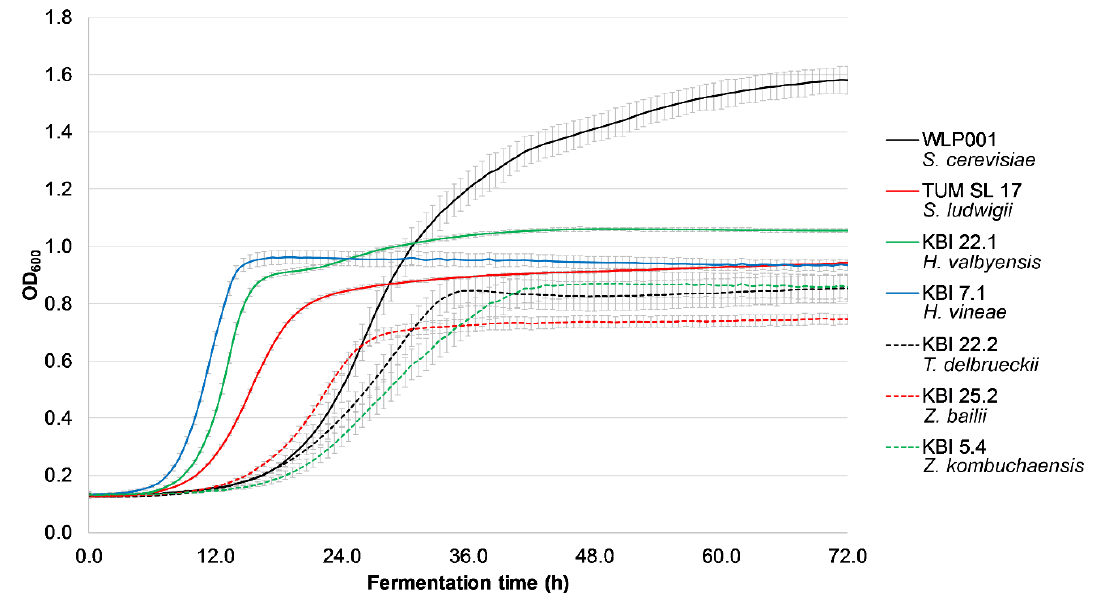
Figure 1. Growth curves of investigated yeast strains in 7 °P wort with 50 IBU.